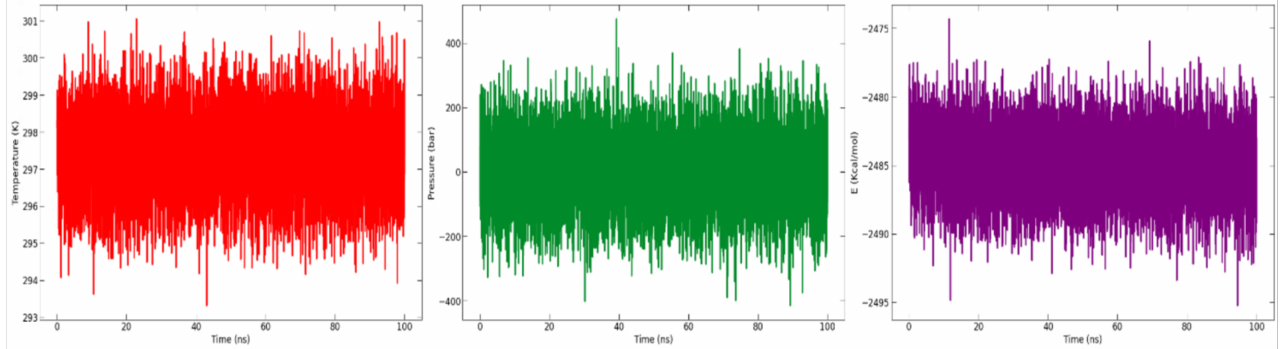
Figure 9. Graph of analysis of temperature (K) (in red), pressure (bar) (in green), and potential energy (kcal/mol) (in purple) throughout the 100 ns simulation